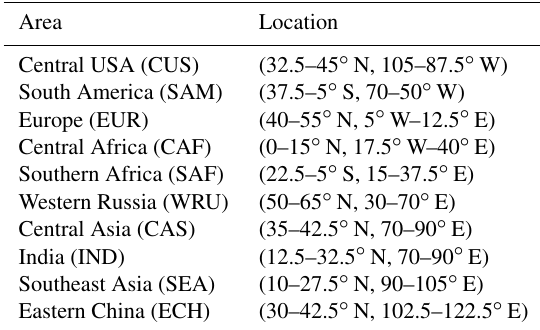
Table 2. List of areas indicated in Fig. 5 and their